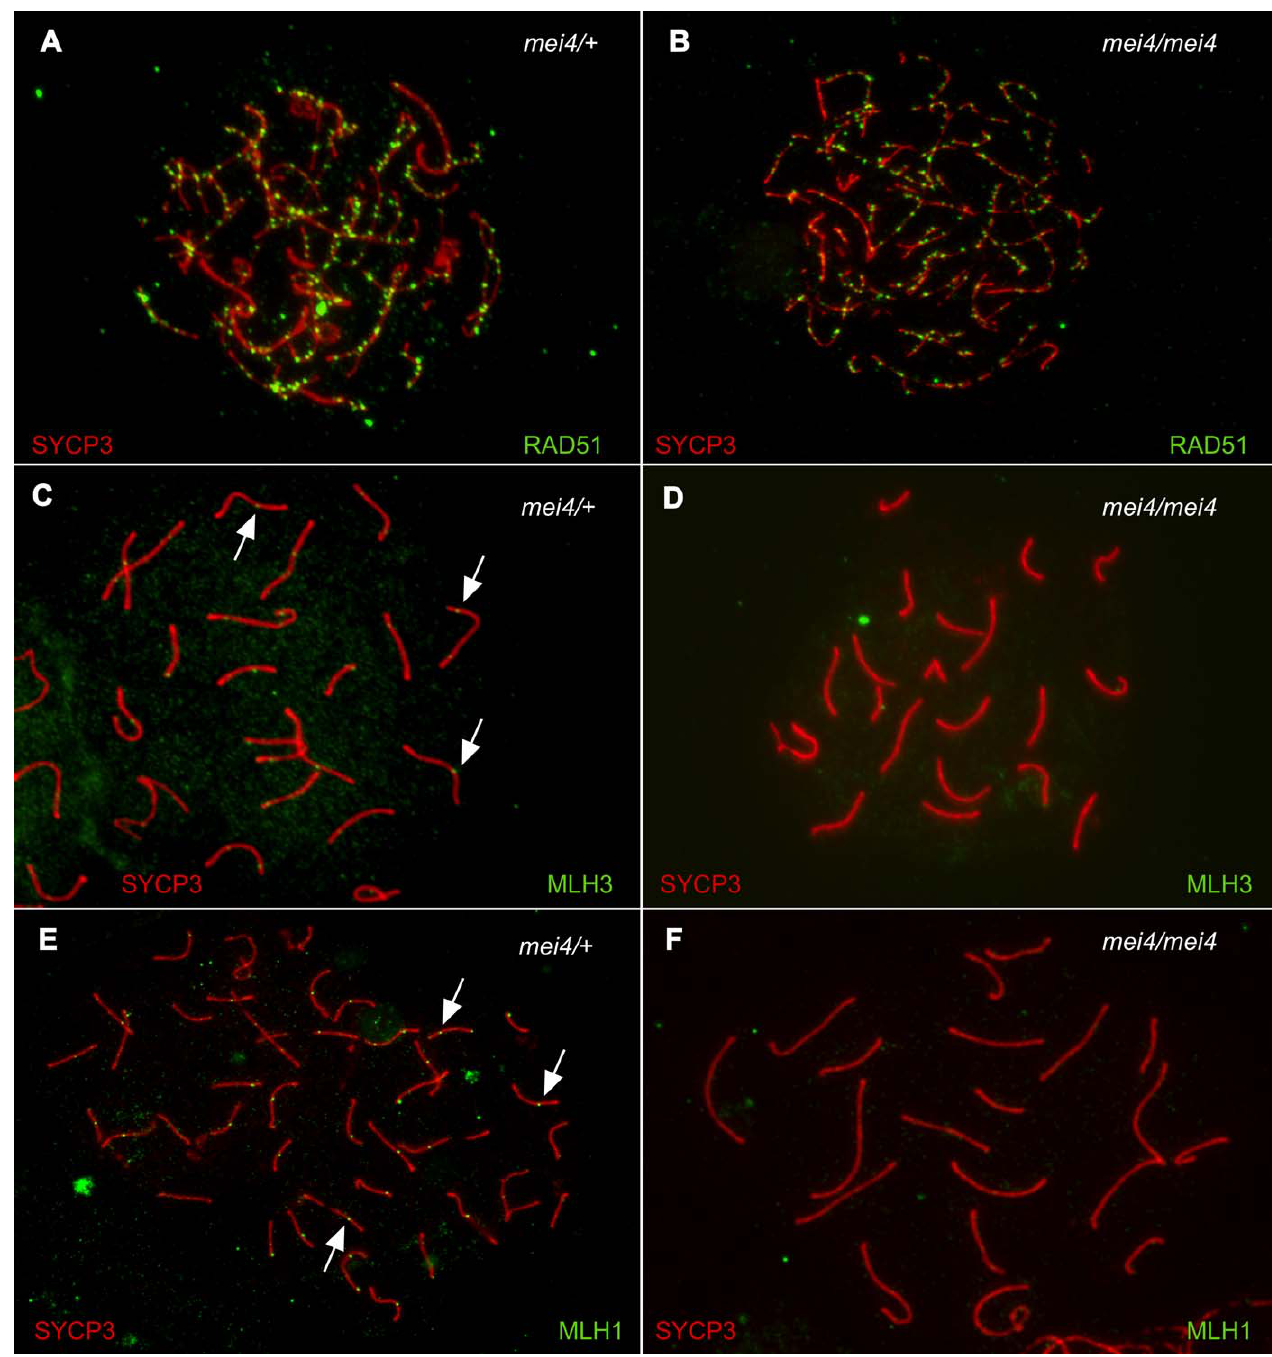
Figure 3. Chromosomes in mei4/mei4 Spermatocytes Contain RAD51 Foci in Zygonema but Lack MLH3 and MLH1 Foci in Pachynema (A and B) The DSB repair protein RAD51 appears in foci (green) on zygotene chromosomes in both mei4/ þ and mei4/mei4 chromosome spreads counter labeled with anti-SYCP3 (red). (C–F) Chromosome spreads from heterozygous ( mei4/ þ ) and mutant ( mei4/mei4 ) spermatocytes were labeled with antibodies to MLH3 (green [C and D]) or MLH1 (green [E and F]) and counter-labeled with anti-SYCP3 (red). MLH3 and MLH1 foci (white arrows) are present on mei4/ þ chromosomes (C) and (E) but not on mei4/mei4 chromosomes (D) and (F).